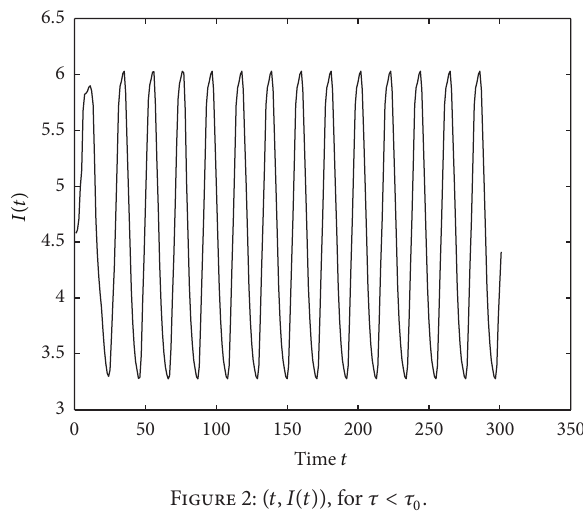
Figure 2: (𝑡,𝐼(𝑡)) , for 𝜏 < 𝜏 0 .